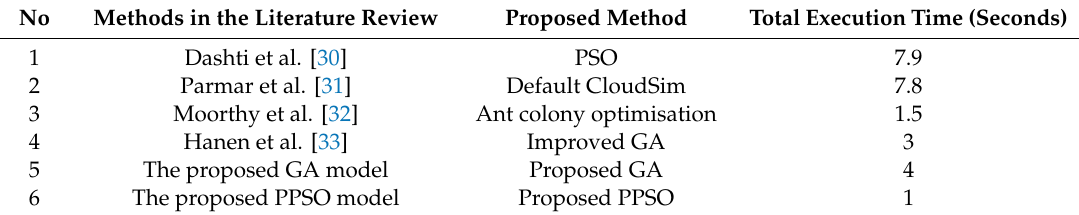
Table 12. Sample of execution time of recent methods in the Literature Review and the proposed model.